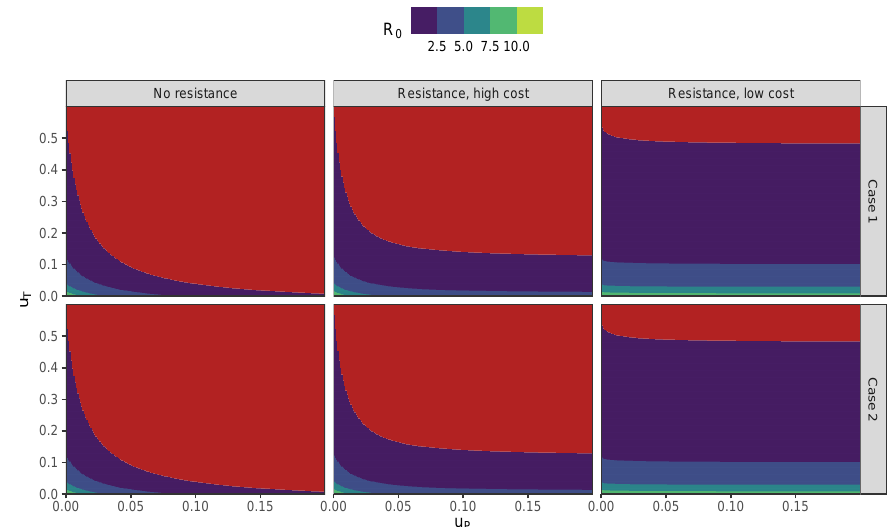
Figure 1. The panel shows the values of R 0 ( u T , u P ) as a function of two controls for two cases described above. The red color corresponds to the case R 0 ≤ 1. We assume a uniform rate of transmission, i.e., β i = β = 0.3 for all i = 1, . . . , 4 and fully efficient treatment, i.e., ζ i = 0, i = 1, . . . , 4. Remaining parameters are: ξ = 5; γ = 3; µ = 0.025; and δ = 0. The subfigures forming the panel correspond to the following values of prophylaxis efficiency coefficients: left, ψ = [ 1, 1, 1, 1 ] ; central, ψ = [ 1, 1, 1, 0 ] ; right, ψ = [ 0, 1, 1, 1 ]